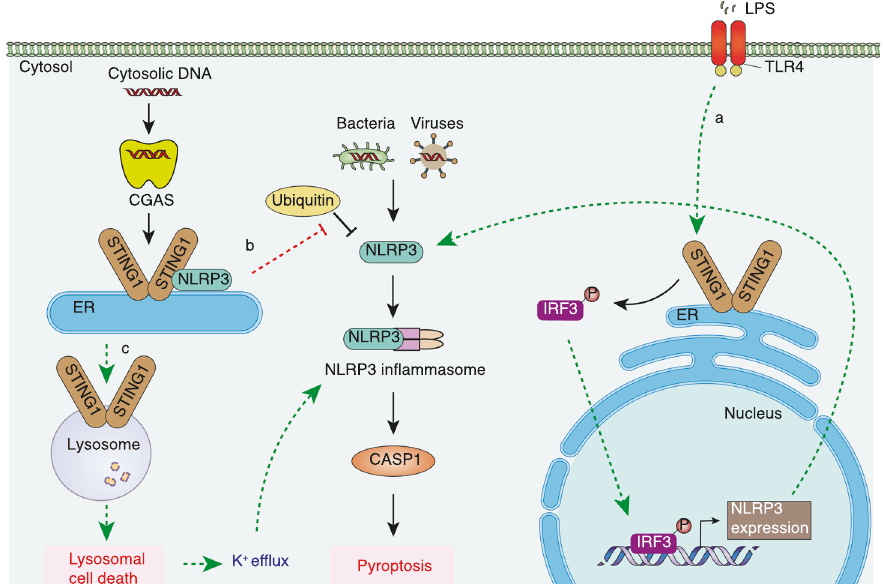
Fig. 4 STING1 in pyroptosis. STING1 activates NLRP3 and subsequent pyroptosis via three pathways: a LPS directly triggers STING1-IRF3 activation via TLR4 and activated IRF3 increases the expression of NLRP3; b STING1 interacts with NLRP3 and prevents ubiquitin-mediated degradation of NLRP3; c STING1 induces lysosomal cell death, causing potassium ef fl ux to activate an NLRP3 in fl ammasome. CASP caspase, CGAS cyclic GMP-AMP synthase, ER endoplasmic reticulum, IRF3 interferon regulatory factor 3, LPS lipopolysaccharide, NLRP3 NLR family pyrin domain containing 3, STING1 stimulator of interferon response cGAMP interactor 1, TLR4 toll-like receptor